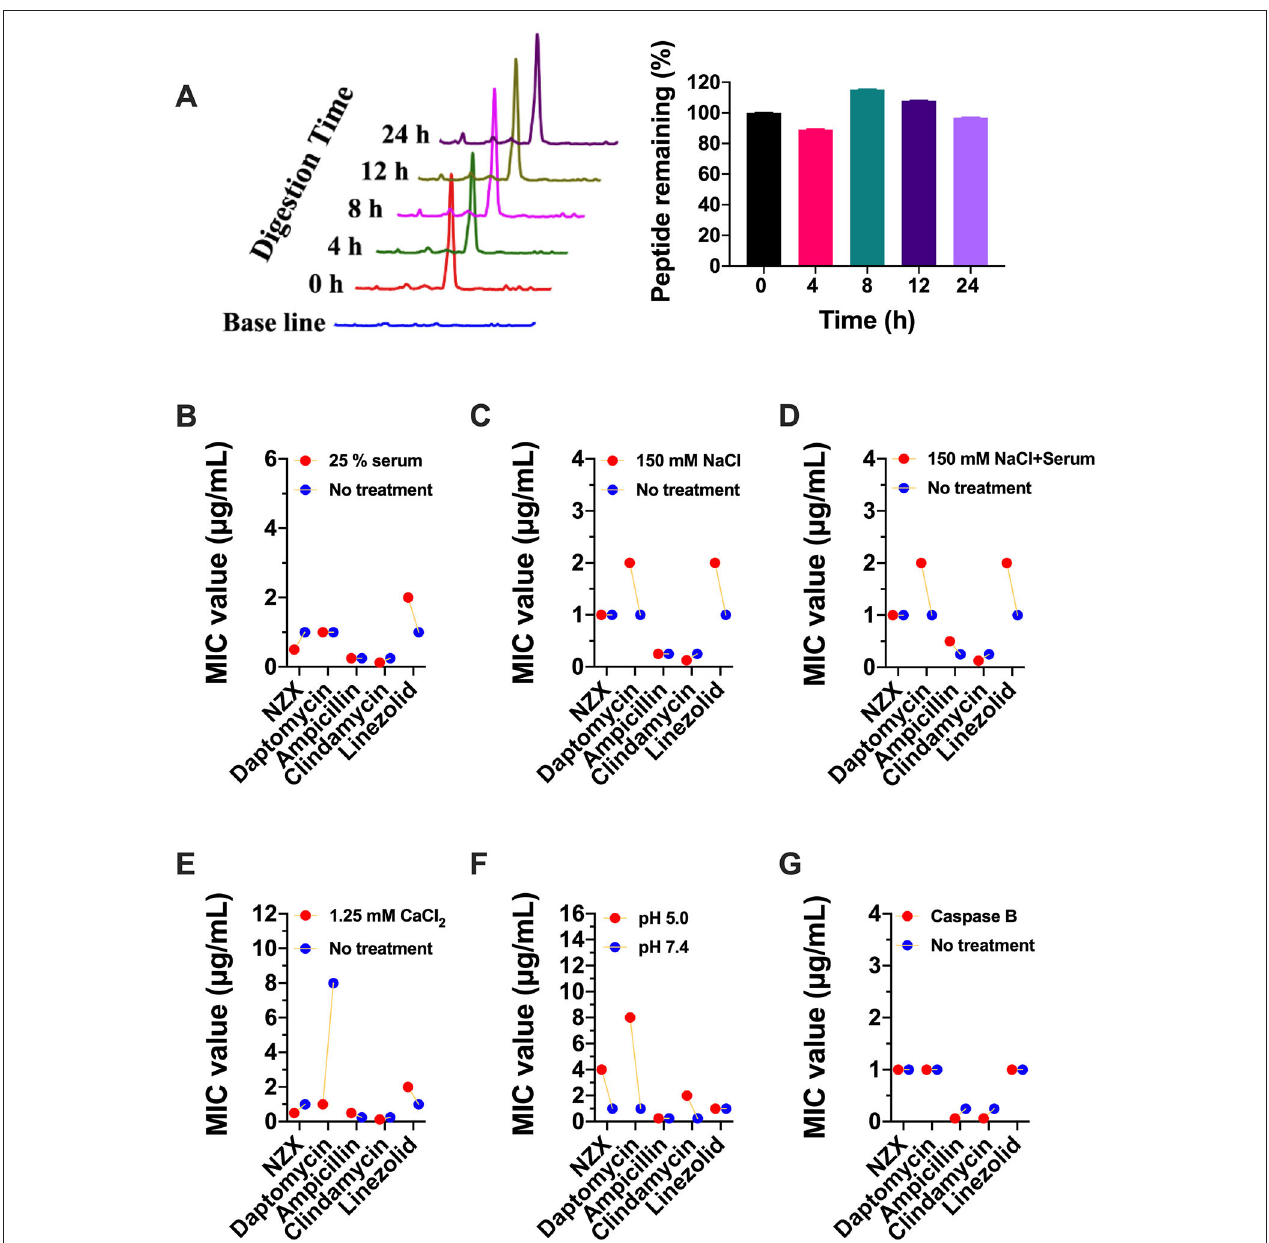
FIGURE 2 | Stability of NZX under different physiological conditions. (A) The peptide remaining after incubation with 25% serum for 24h in serum. (Left) chromatogram; (Right) histogram. (B–G) The activity of NZX exposure to different physiological conditions for 24h. No treatment: with the only presence of the MH